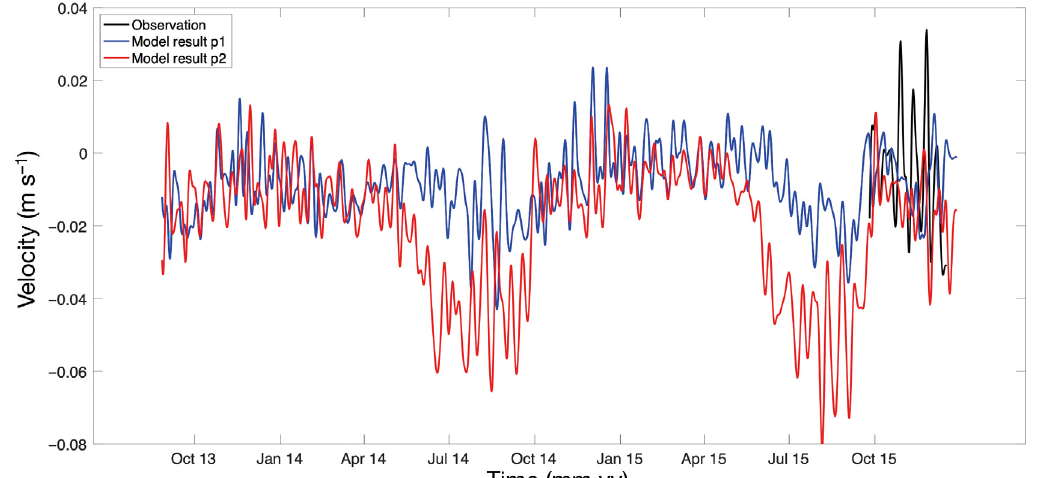
Fig. 6. Time series from the model results of 7 d low-passed north−south current component close to the bottom at Sites P1 and P2. The black line is a similar current component from the observations near